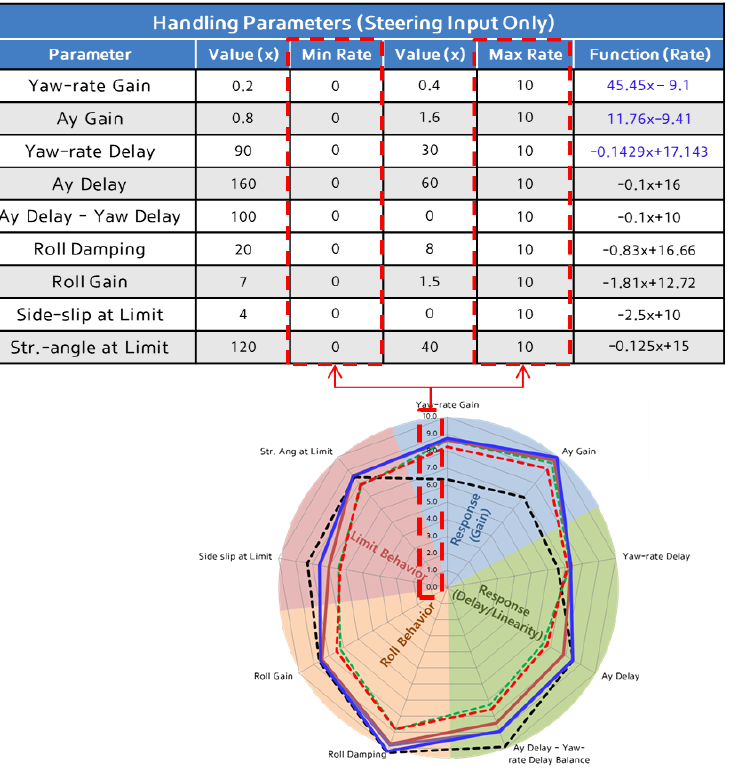
Figure 2. Relational expression between the handling subjective test items and objective test factors.